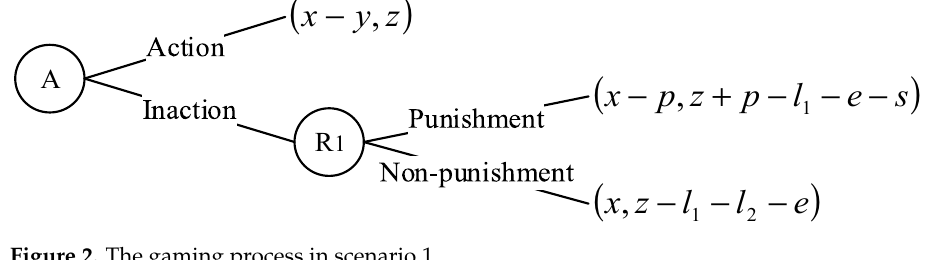
Figure 2. The gaming process in scenario 1.